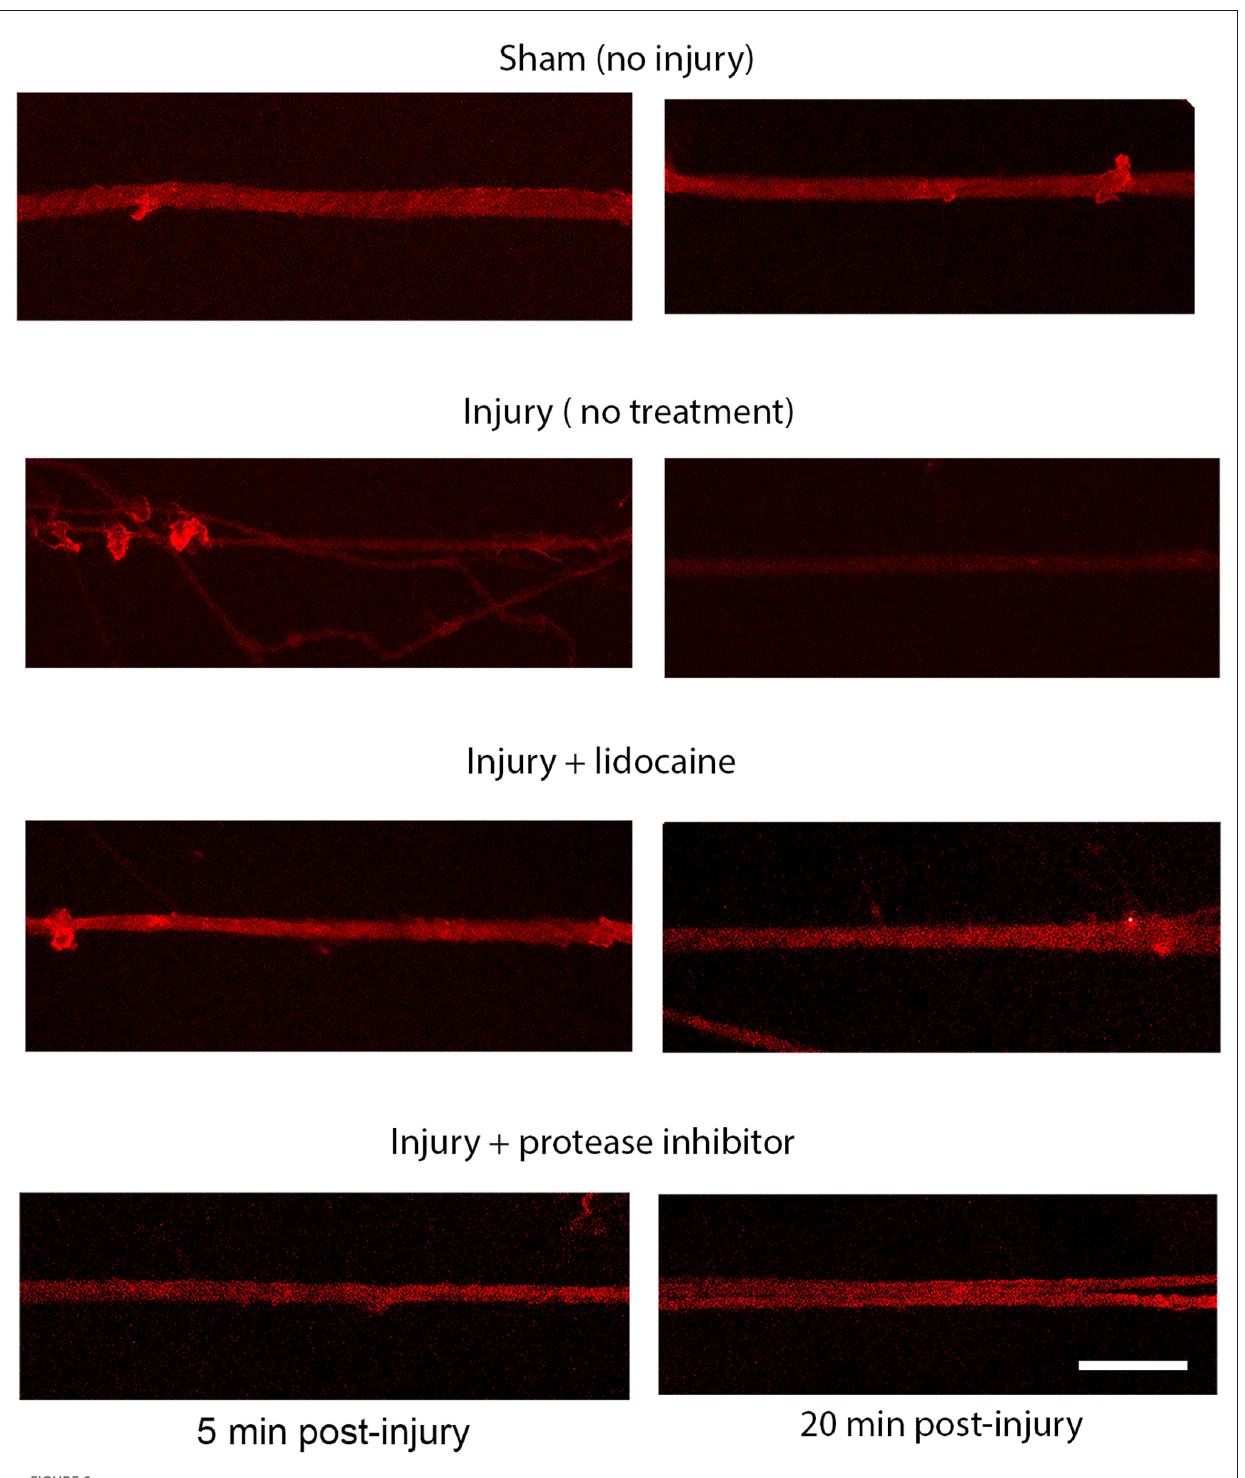
FIGURE6 Proteolysis of the sodium channel III-IV loop post injury in DRGN axons. Expression of the NaCh III-IV loop after 60% stretch injury is attenuated at 5 min and lost completely by 20 min. Blocking sodium channels with lidocaine prevents the cleavage of the III-IV loop. Cleavage is also prevented by blocking protease activity. This mechanism is similar to the response in injured cortical neurons. Scale bar = 10 µ m.